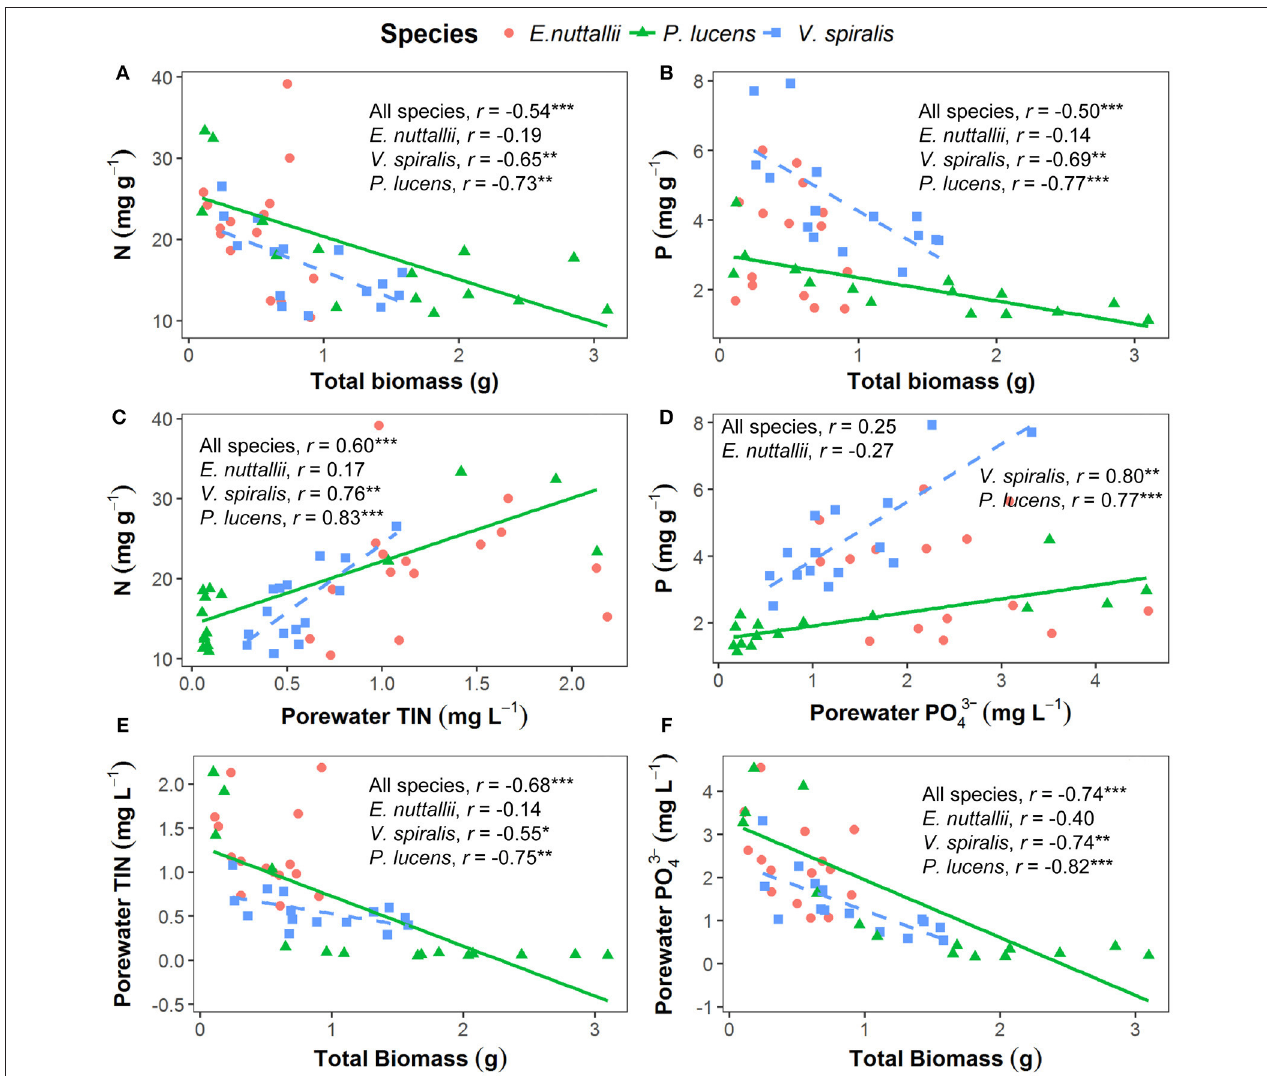
FIGURE 3 | Pearson’s correlations of plant total biomass, plant nutrient contents and porewater nutrient concentrations for the three tested species. Each species has 15 data points from every temperature treatment, in total 45 points for each panel. Lines in the graph indicate that factors are significantly correlated at the species level ( p < 0.05). (A) N content in the plants in relation to the total plant biomass. (B) P content in the plants in relation to the total plant biomass. (C) N content in the plants in relation to the total inorganic nitrogen concentration in the porewater. (D) P content in the plants in relation to the phosphorous concentration in the porewater. (E) Total plant biomass in relation to the total inorganic nitrogen concentration in the porewater. (F) Total plant biomass in relation to the phosphorous concentration in the porewater. * p < 0.05, ** p < 0.01, *** p <